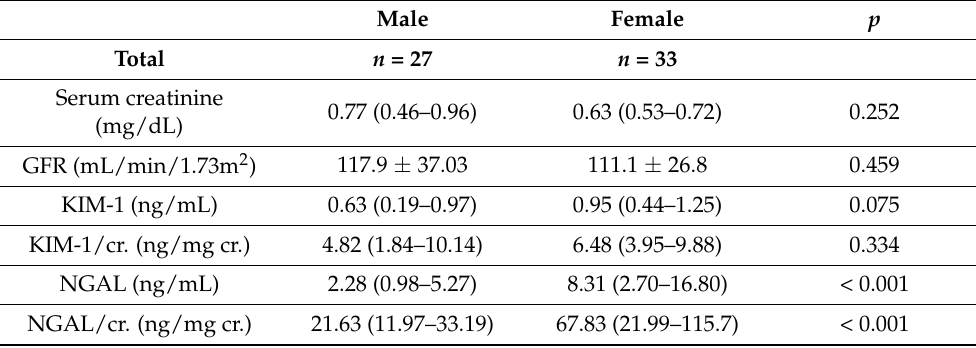
Table 3. Urine concentration of biochemical parameters in survivors of solid tumors according to